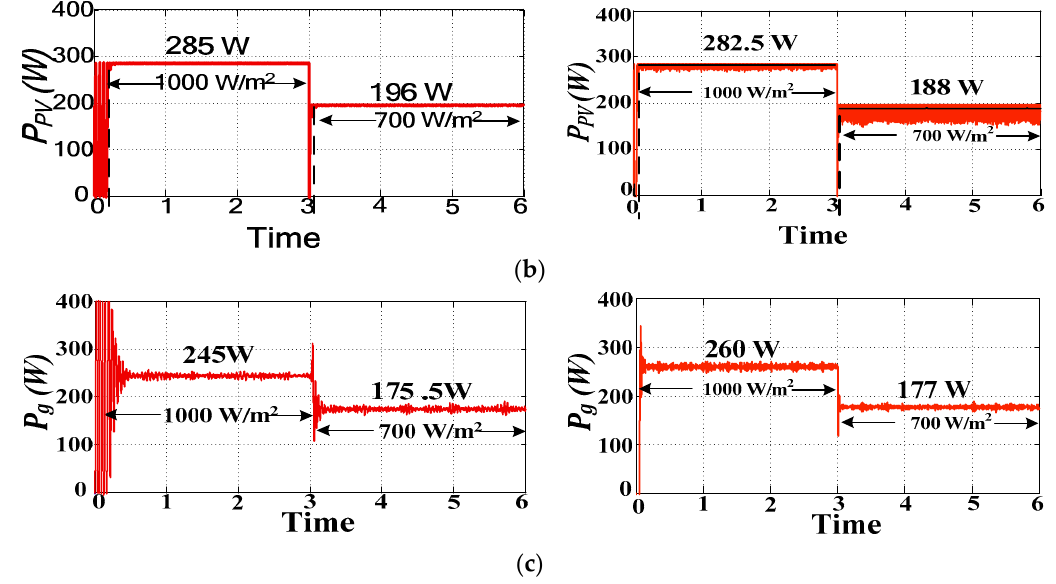
Figure 10. PCHC performance comparison when applying L dc of 150 mH and 50 mH under irradiance variation: ( a ) DC-link current, ( b ) PV power, and ( c ) average grid power.